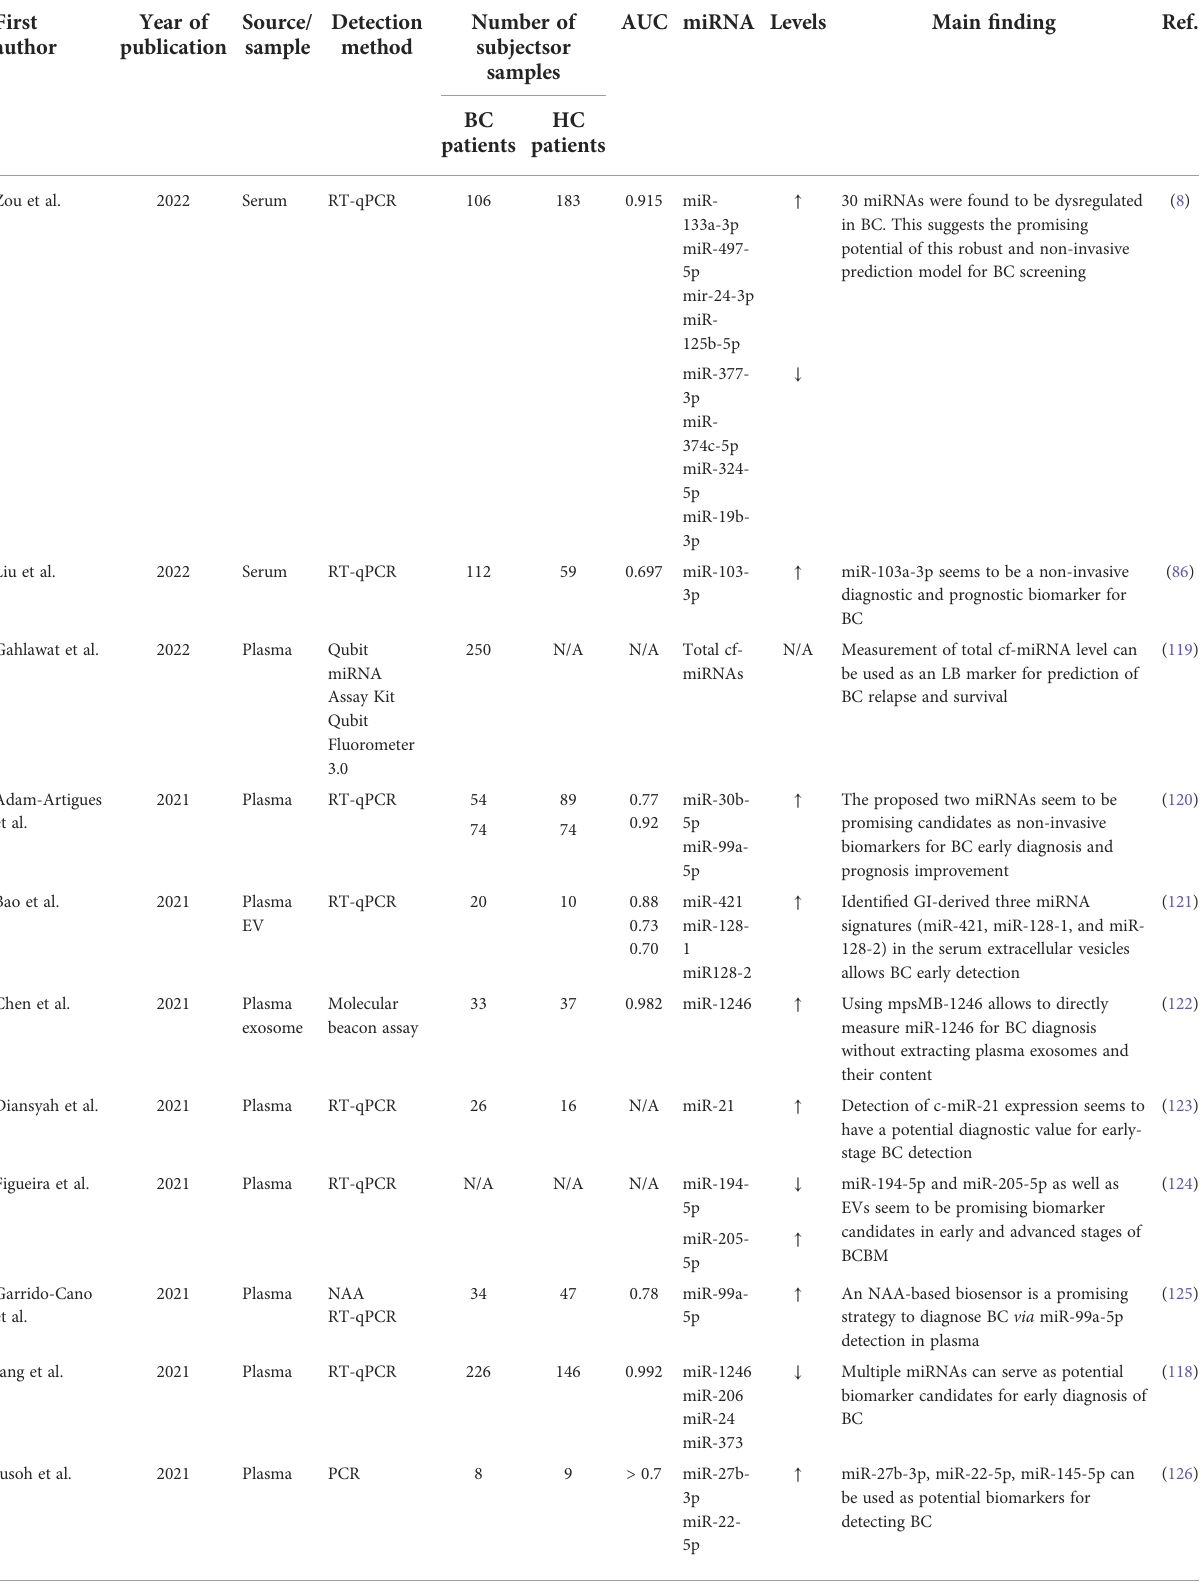
TABLE 3 Summary of recent studies since 2015 on altered levels of circulating miRNAs in breast